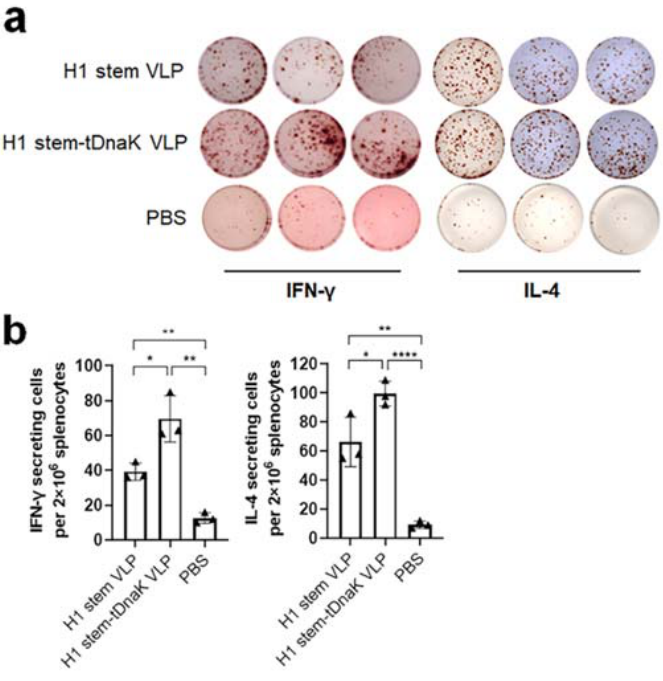
Figure 5. ELISPOT analysis of cellular immune responses. Mouse splenocyte samples ( n = 3 per group) were collected on day 4 post sublethal-dose infections with 0.2 × LD 50 of the NJ76 H1N1 virus. ( a ) Inactivated NJ76 H1N1 influenza virus re-stimulated IFN- γ - and IL-4-secreting cells were determined using ELISPOT assays. ( b ) The spot numbers of inactivated H1N1 virus-restimulated groups were quantified and compared in bar charts. The results were presented as means ± standard deviation. Each symbol represents the average spot number of the parallel samples from each mouse. The statistical significance was analyzed by t -test. *, **, and **** represent p < 0.05, p < 0.01, and p < 0.0001, respectively. N.S. indicates no significance.